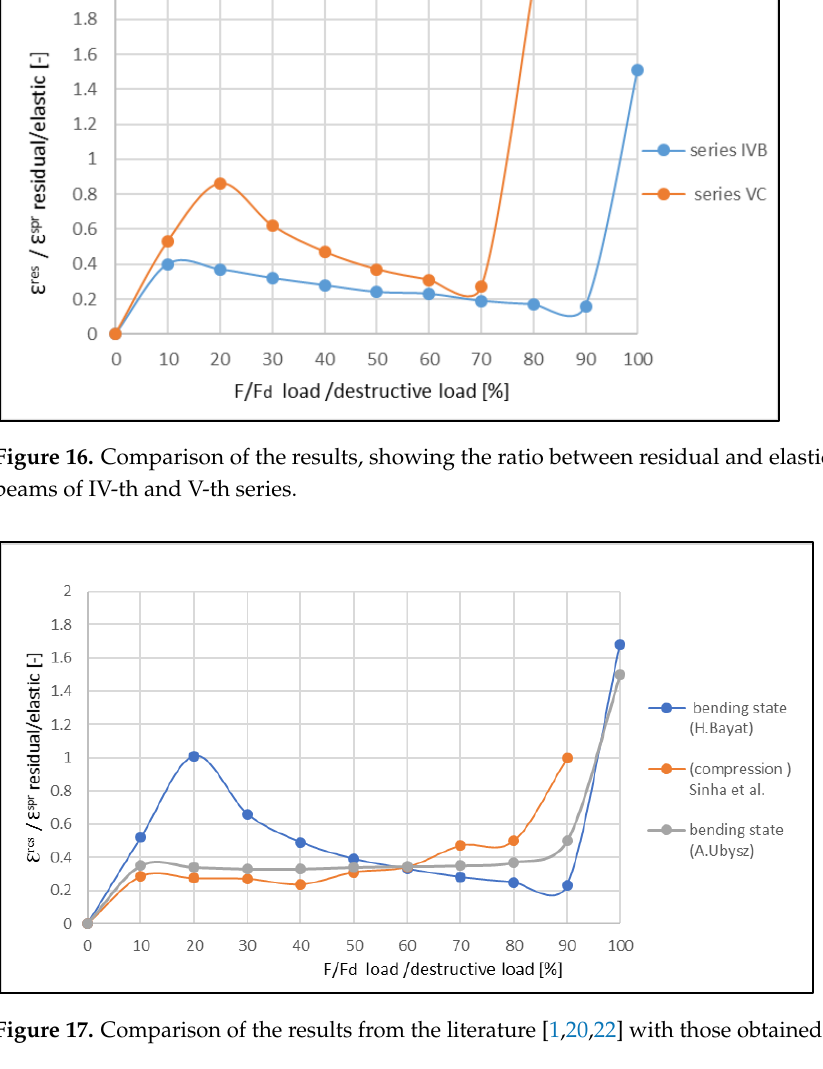
Figure 15. Example graph showing the ratio between residual and elastic strains regarding the ratio between the applied load and destructive load (beams of IV-th series).